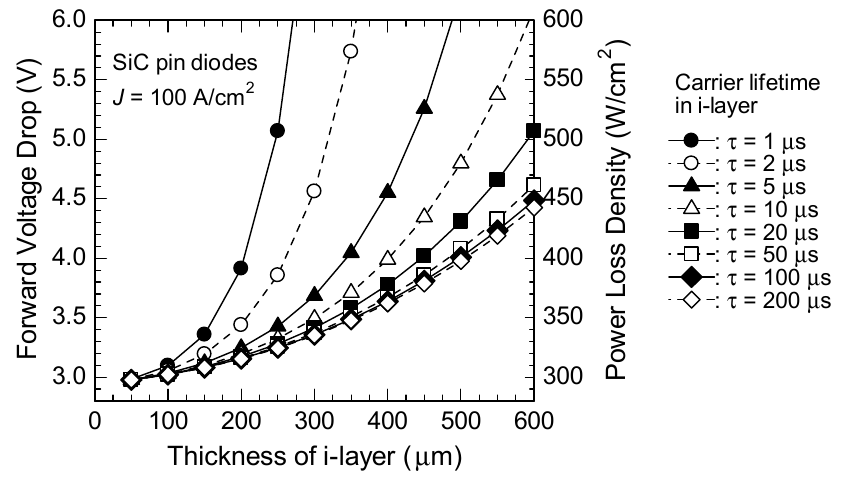
Figure 5. Dependence of the forward voltage drop at a current density of 100 A/cm 2 for SiC pin diodes on the i-layer thickness. Here the carrier lifetime in the i-layer was varied from 1 µs to 200 µs. The right axis indicates the density of on-state loss at 100 A/cm 2 .